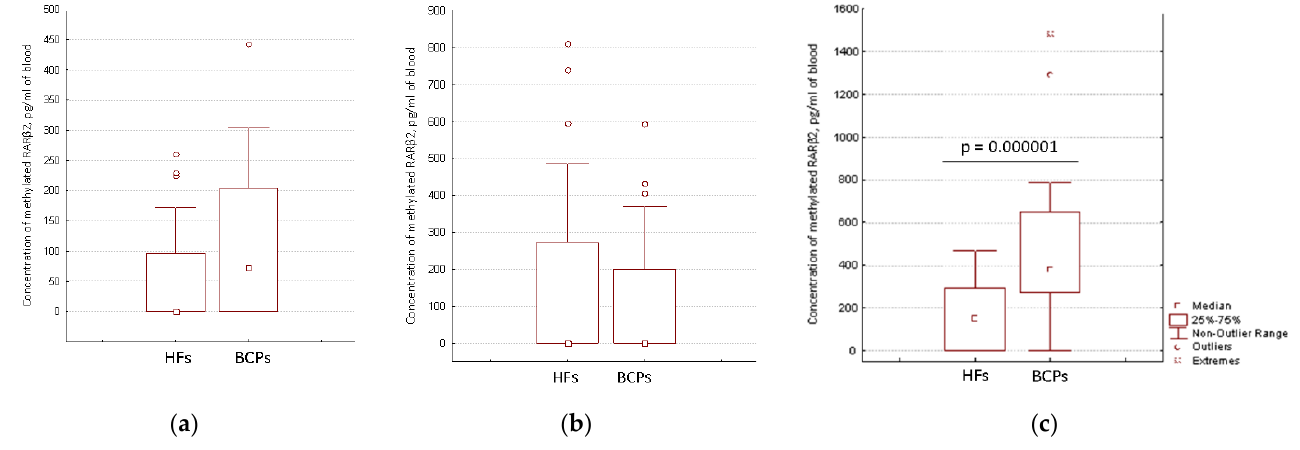
Figure 3. Concentration of aberrantly methylated RAR β 2 in blood of HFs and BCPs. ( a ) Plasma; ( b ) PBS – EDTA eluate; ( c ) Trypsin eluate.